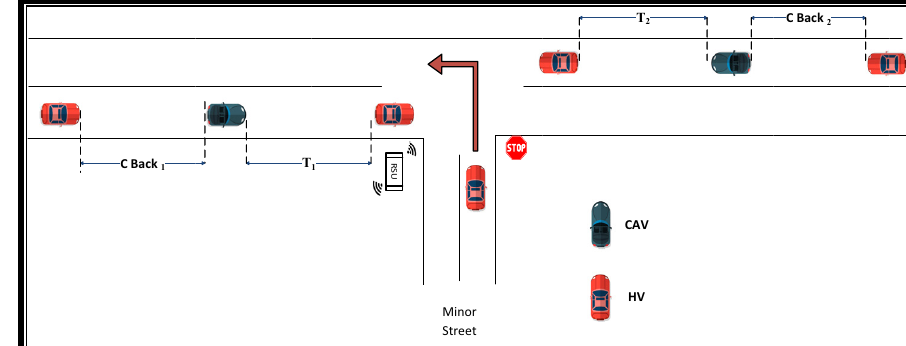
Figure 8: Road entry through a left turn.